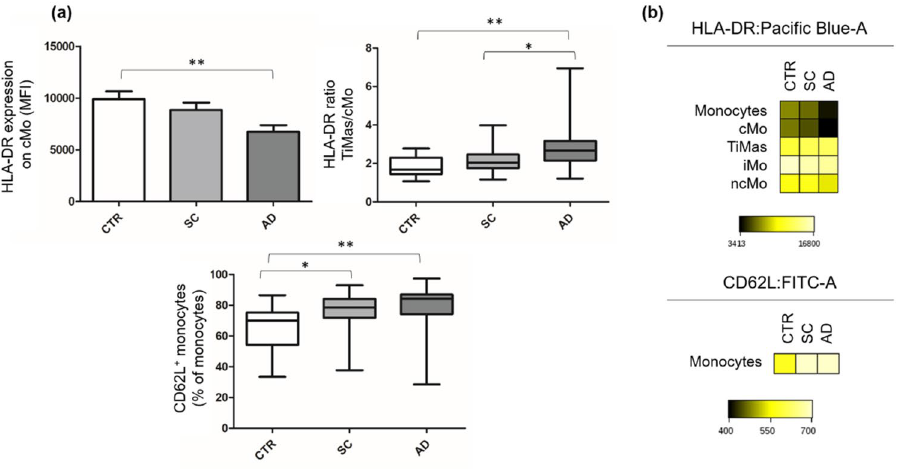
Figure 2. HLA-DR and CD62L expression on monocytes. Panel ( a ) HLA-DR and CD62L expression on monocytes of healthy controls, stable cirrhosis and in acute decompensation of cirrhosis.Values are represented as MFI of HLA-DR expression and percentage of CD62L + monocytes. Panel ( b ) Heatmap of the FCS files of 30 CTR, 29 SC and 39 AD merged together. The colors in the heatmap represent the median of the intensity of HLA-DR and CD62L expression on monocytes, varying from black for lower expression to light yellow for higher expression. * p ≤ 0.05; ** p ≤ 0.01. AD Acute decompensation of cirrhosis, cMo Classical monocytes, CTR Healthy controls, MFI Mean fluorescence intensity, SC Stable cirrhosis, TiMas Tissular macrophages. Differences were tested using Kruskal–Wallis or ANOVA/Bonferroni. Parametric variables are represented by column chart.